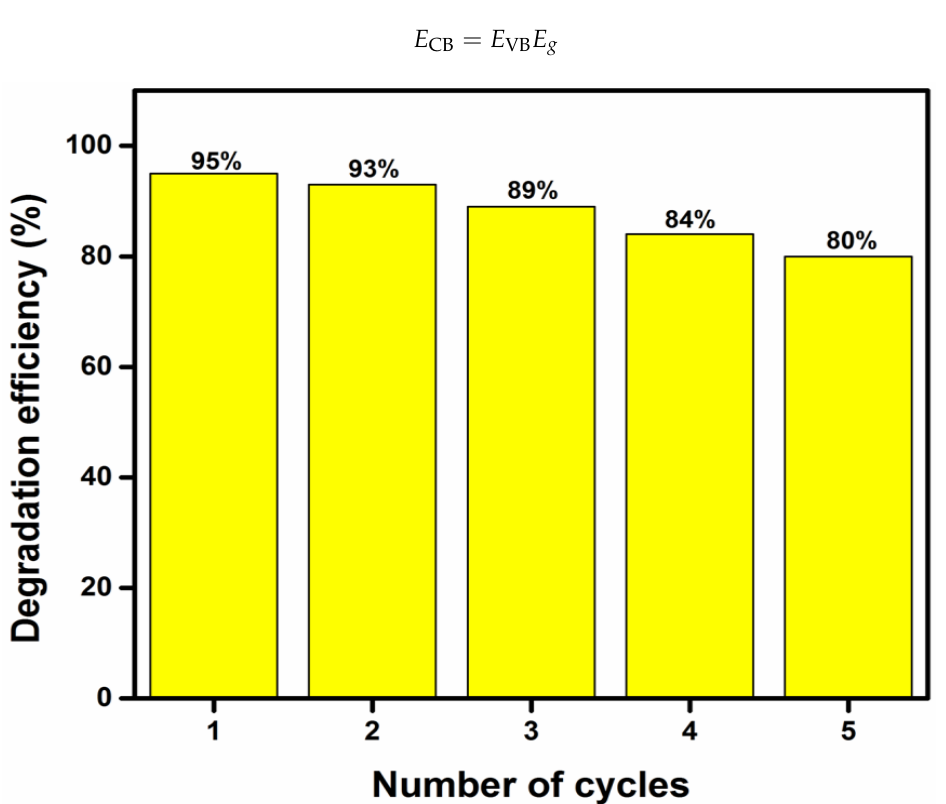
Figure 9. Reusability of 3APMZ heterojunction in five consecutive runs.